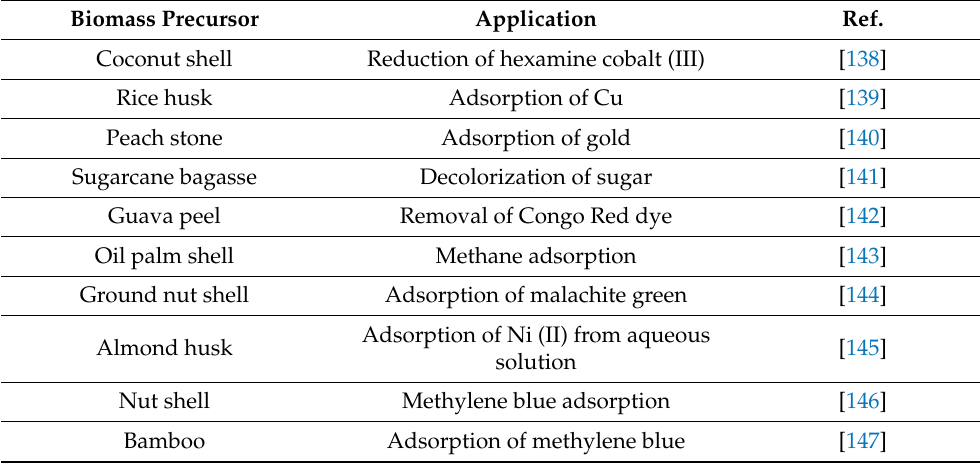
Table 5. Applications of activated carbon from